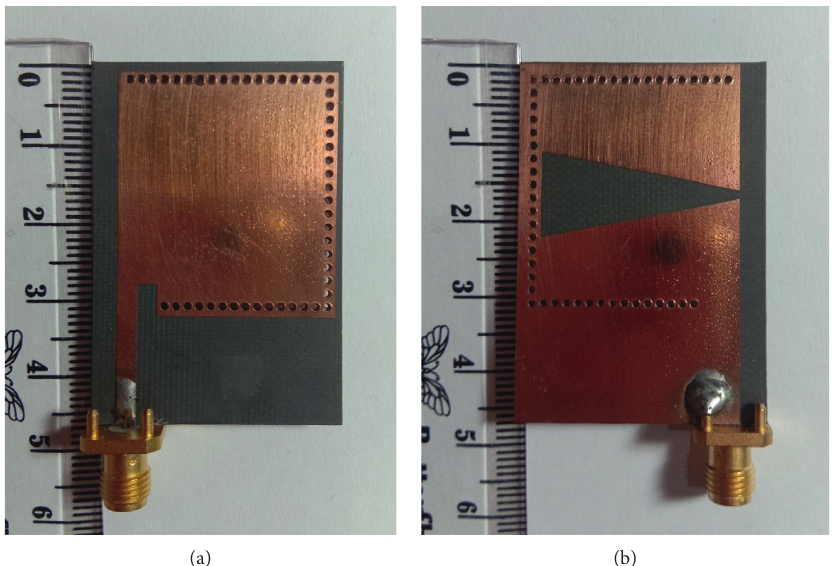
Figure 9: Prototype of the proposed SIW-CBS antenna using a triangular slot: (a) top layer and (b) ground